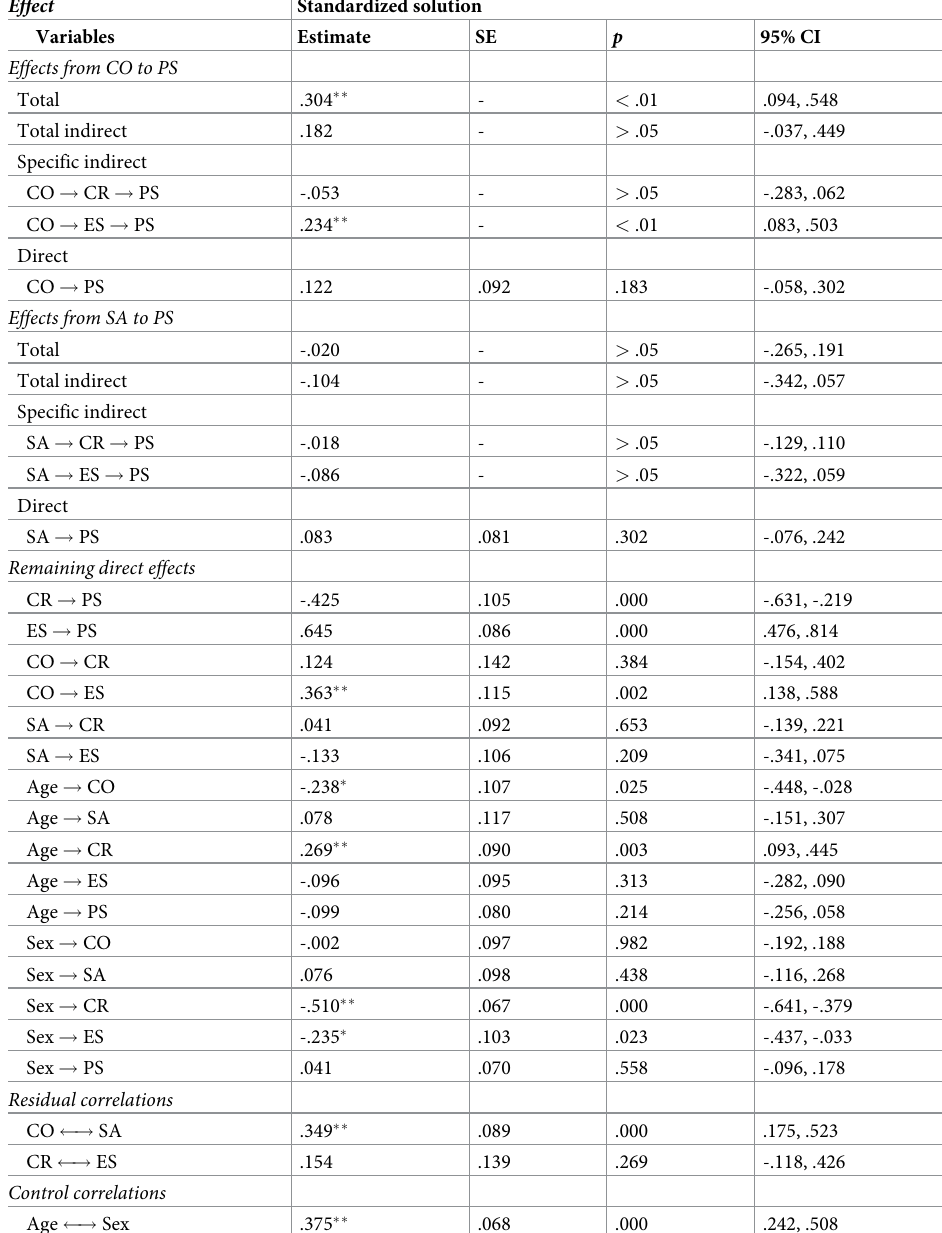
Table 2. Regressions weights and correlations from the estimated SEM